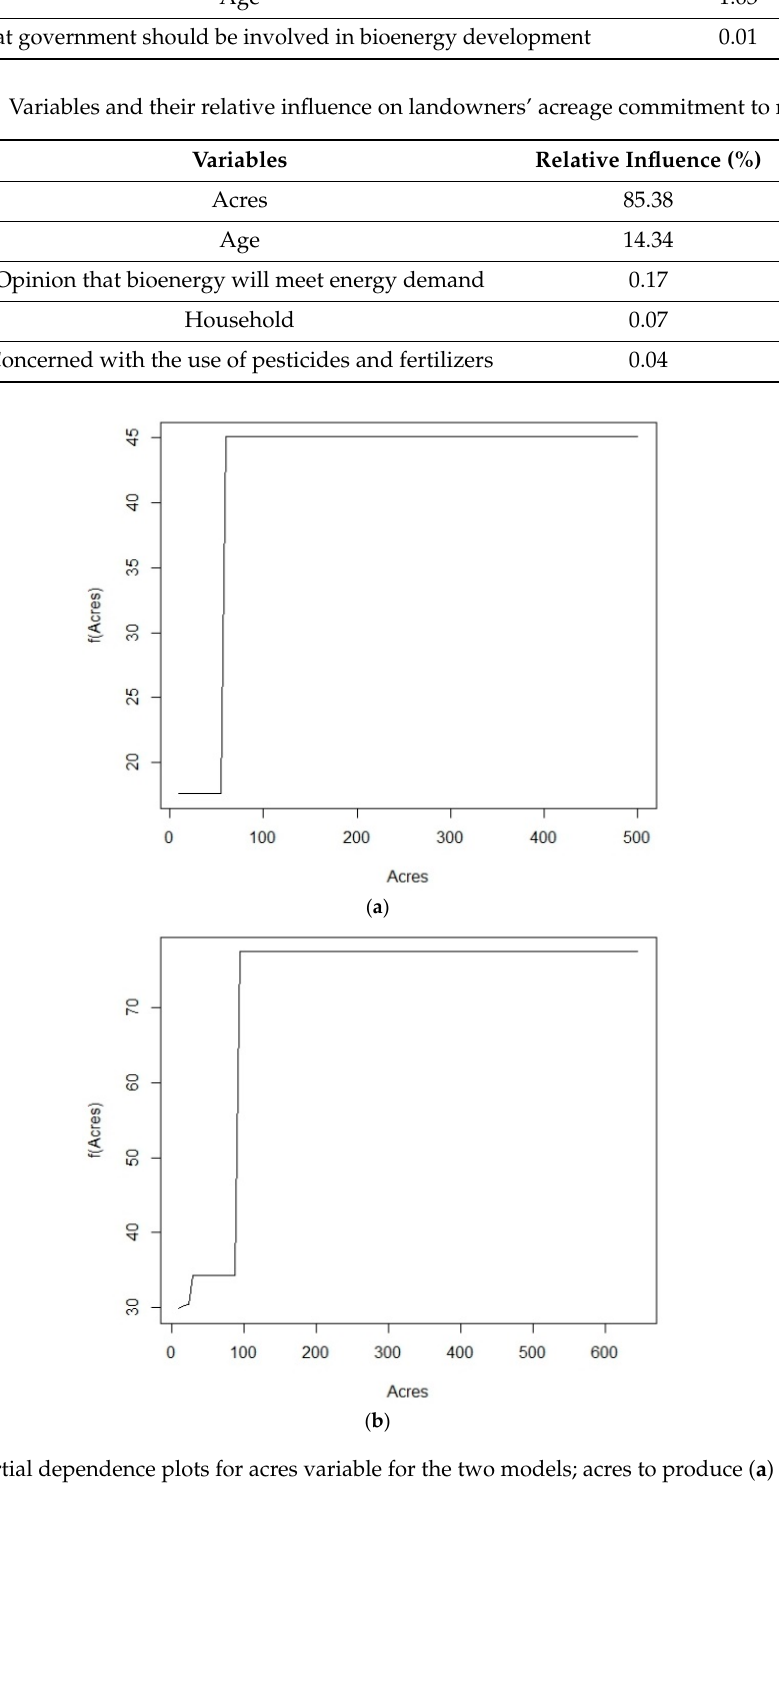
Figure 10. Interaction of variables for acres commitment model to produce.